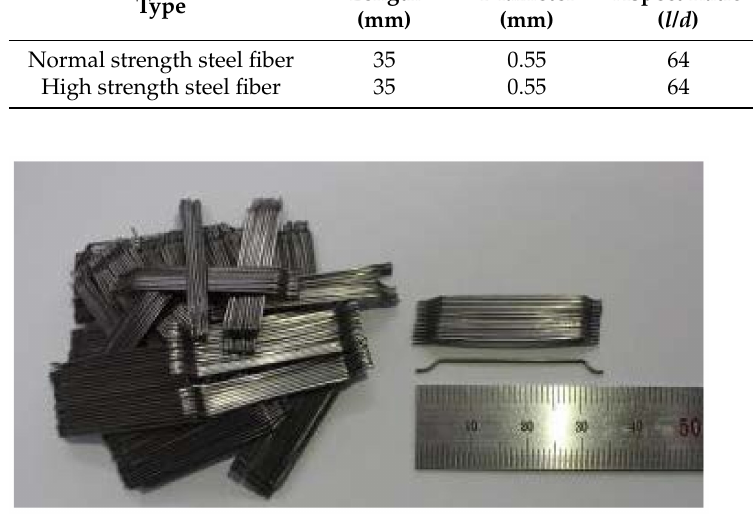
Figure 2. Shape and dimension of steel fiber.